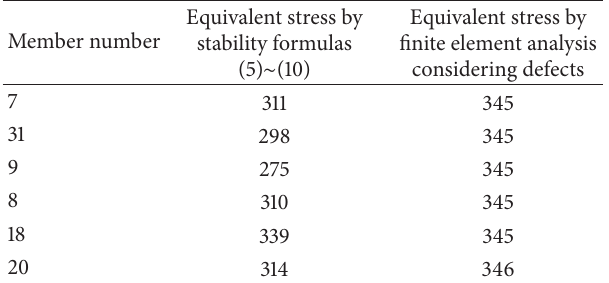
Table 3: Comparison between stability formulas and finite element analysis (negative